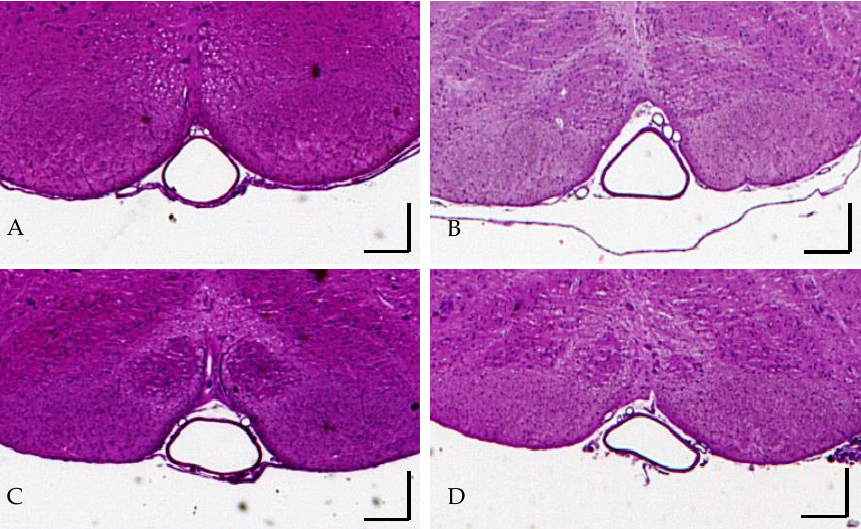
Figure 3. Representative examples of mid-basilar artery vascular diameters of ( A ) sham conditioning (n = 8), ( B ) true conditioning (n = 9), ( C ) vehicle (n = 9) and ( D ) resveratrol conditioning groups (n = 7) (bar length is 0.2 mm). 3.3. Histological Hippocampal Cell Counts Mean hippocampal neurons/mm counts did not differ between the groups (Table 1, Figure 4). Figure 4. Hippocampal cell counts of ( A ) sham conditioning (n = 9), ( B ) true conditioning (n = 9), ( C ) vehicle (n = 9) and ( D ) resveratrol conditioning groups (n = 7) (bar length is 10 µm). 4. Discussion Cerebral vasoconstriction remains an important pathological finding in SAH, even though its role as the only contributor to DCI has been questioned recently [11]. In the present study we were able to show a vasoprotective effect of remote limb ischemic con- ditioning on basilar artery diameter; however, we were not able to demonstrate a similar effect with resveratrol. We did not find a protective effect of either conditioning paradigm on neurological and behavioral outcomes or hippocampal cell counts. In contrast to our findings, Karaoglan et al. found that three daily doses of intravenous resveratrol 10 mg/kg improved basilar artery diameters and wall thickness in a single injection rodent SAH